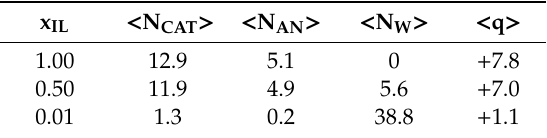
Table 1. Average values of the number of cations, <N CAT >, number of anions, <N AN >, number of water molecules, <N W >, and charge <q> of the clusters obtained for each system. x IL